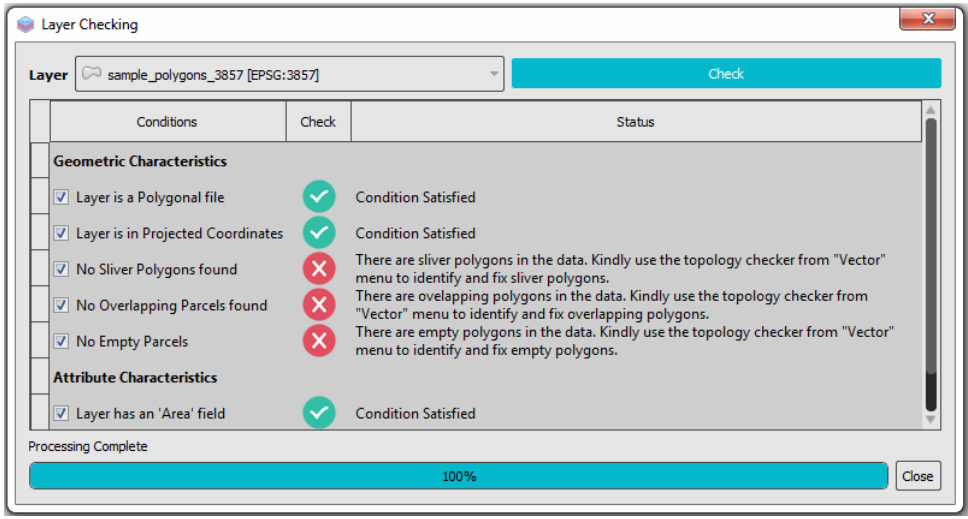
Figure 7. Layer checking function.